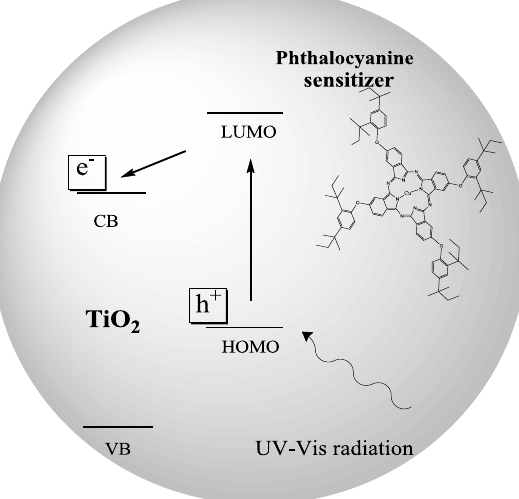
Figure 6. Representation of charge separation enhancement by the use of